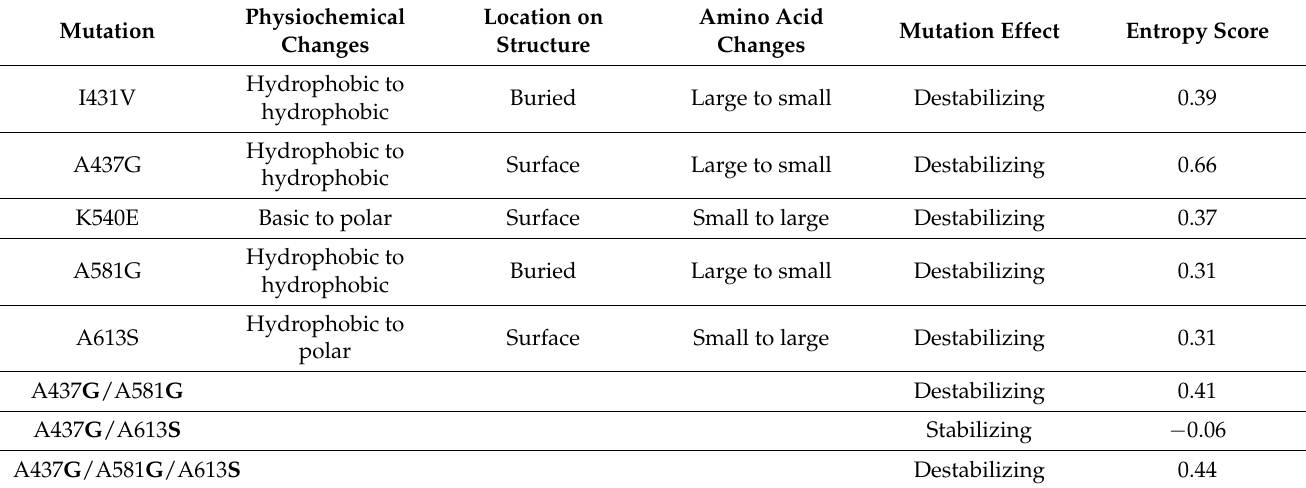
Table 3. Identified changes in the amino acid